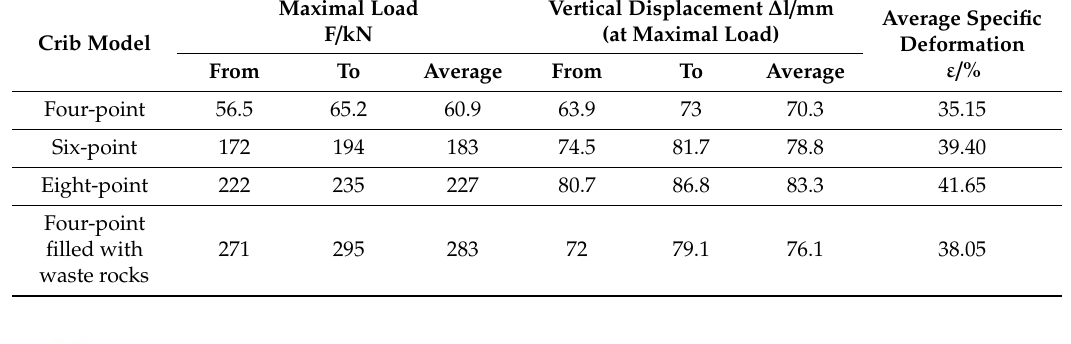
Figure 8. Models of the wooden cribs after compression tests: ( a ) Four-point; ( b ) Six-point; ( c ) Eight- point; ( d ) Four-point filled with waste rocks.